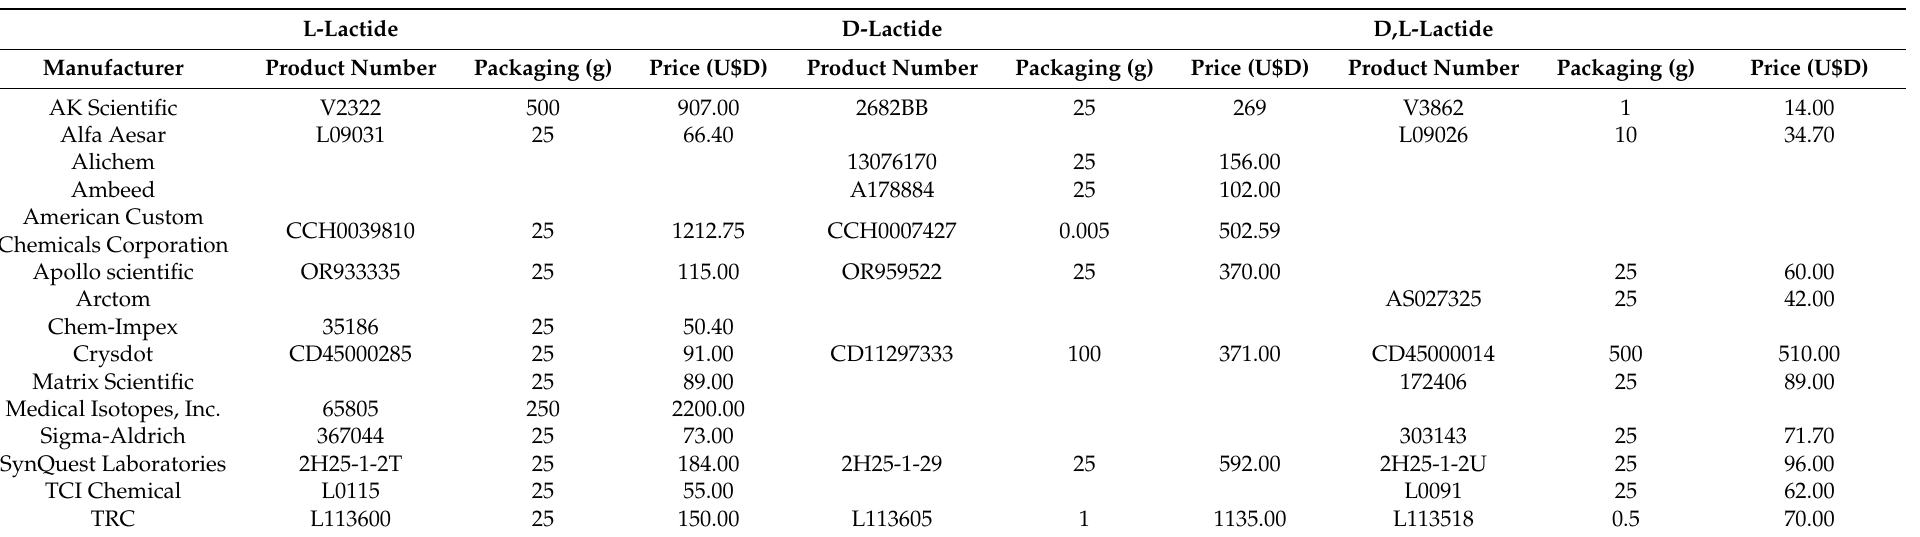
Table 1. Recent price market of L-lactide (3s-cis-3,6-dimethyl-1,4-dioxane-2,5-dione) with 98% of